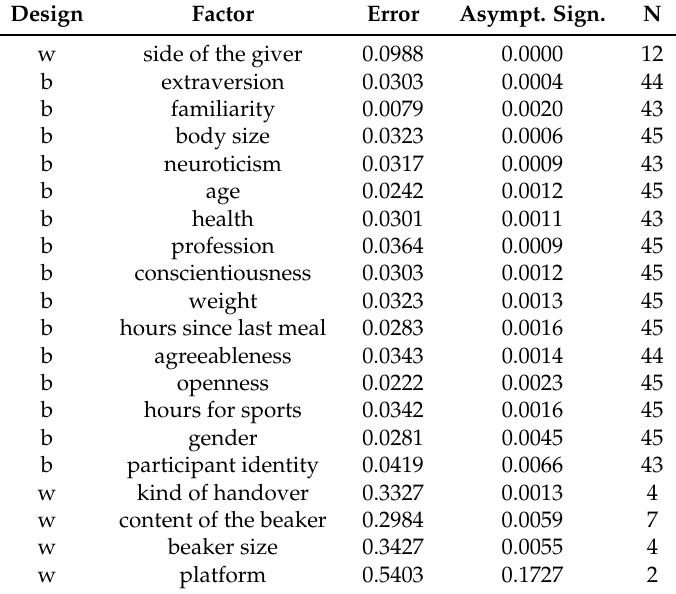
Table 4. Supervised learning: Results of trialwise cross-validation.